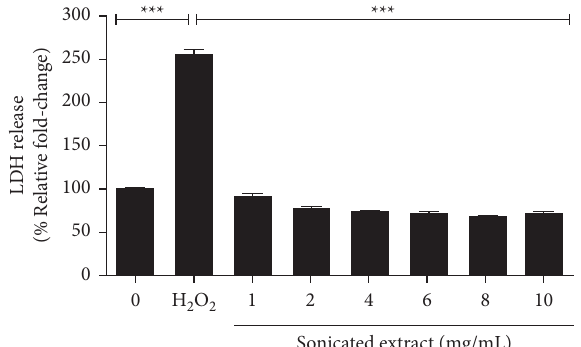
Figure 3: Te cell damage efect of sonicated extract on PC-3 cells. PC-3 cells were treated with sonicated extracts and incubated for 24h, and LDH released into the media was measured at 490nm using a microplate reader. Te graph presents the LDH release in medium collected from sample groups. Data are presented as the means ± SEM ( n � 3). ( p < 0 . 001 ∗∗∗ was considered signifcant compared between the negative control and positive group, positive and treated control) of three independent